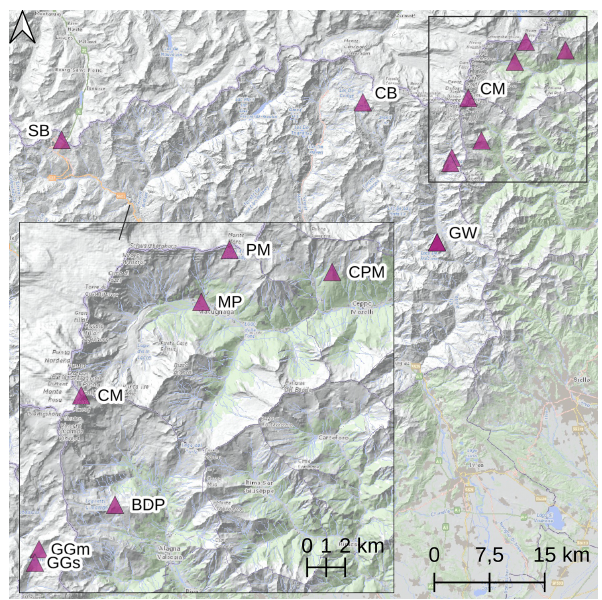
Figure 3. Location of the meteorological stations used: Capanna Regina Margherita (CM), Macugnaga Pecetto (MP), Ceppo Morelli (CPM), Passo del Moro (PM), Bocchetta delle Pisse (BDP), Col du Grand St Bernard (SB), Valtournenche–Cime Bianche (CB), Gressoney-la-Trinité – Gabiet (GGm and GGs) and Gressoney- Saint-Jean – Weissmatten (GWm and GWs). The location of the meteorological station at Weissmatten and the location of snow measurements are only a few metres apart, so only one point is re- ported (identified with GW). In the bottom left panel a zoom over some stations is included. All stations belong to Arpa Piemonte with the exclusion of CB, GGm, GGs, GWm and GWs, which belong to the Aosta Valley Region, and SB, which belongs to the National Oceanic and Atmospheric Administration (NOAA). Source of the basemap: Arpa Piemonte